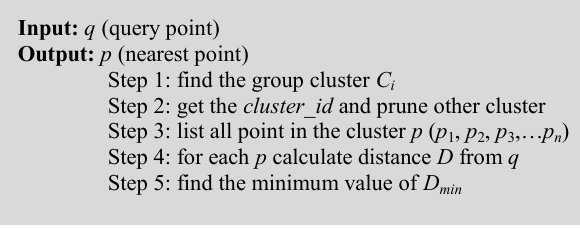
Figure 2. Single Nearest Neighbour workflow